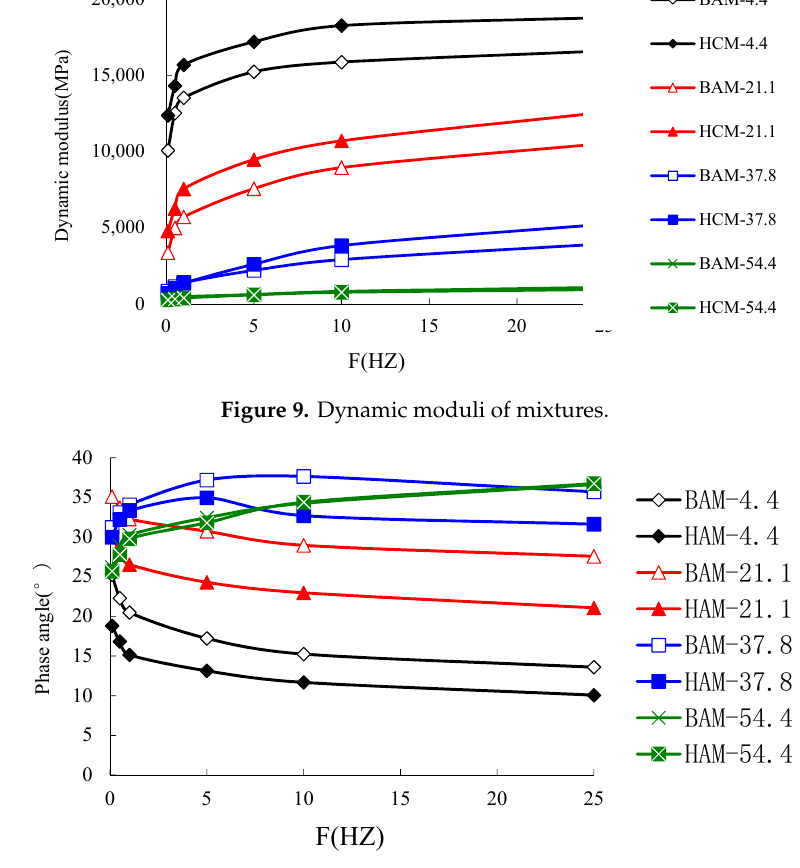
Figure 10. Phase angles of mixtures.